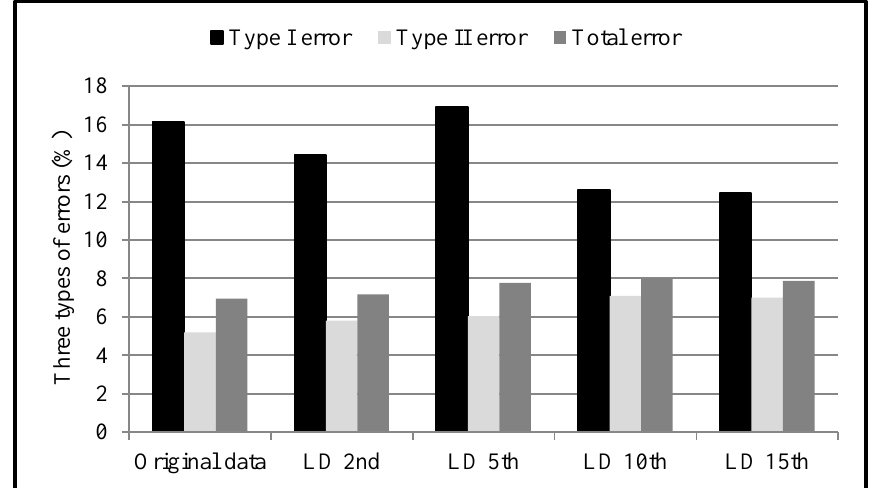
Figure 20. Accuracy comparison of the proposed algorithm under different point density.